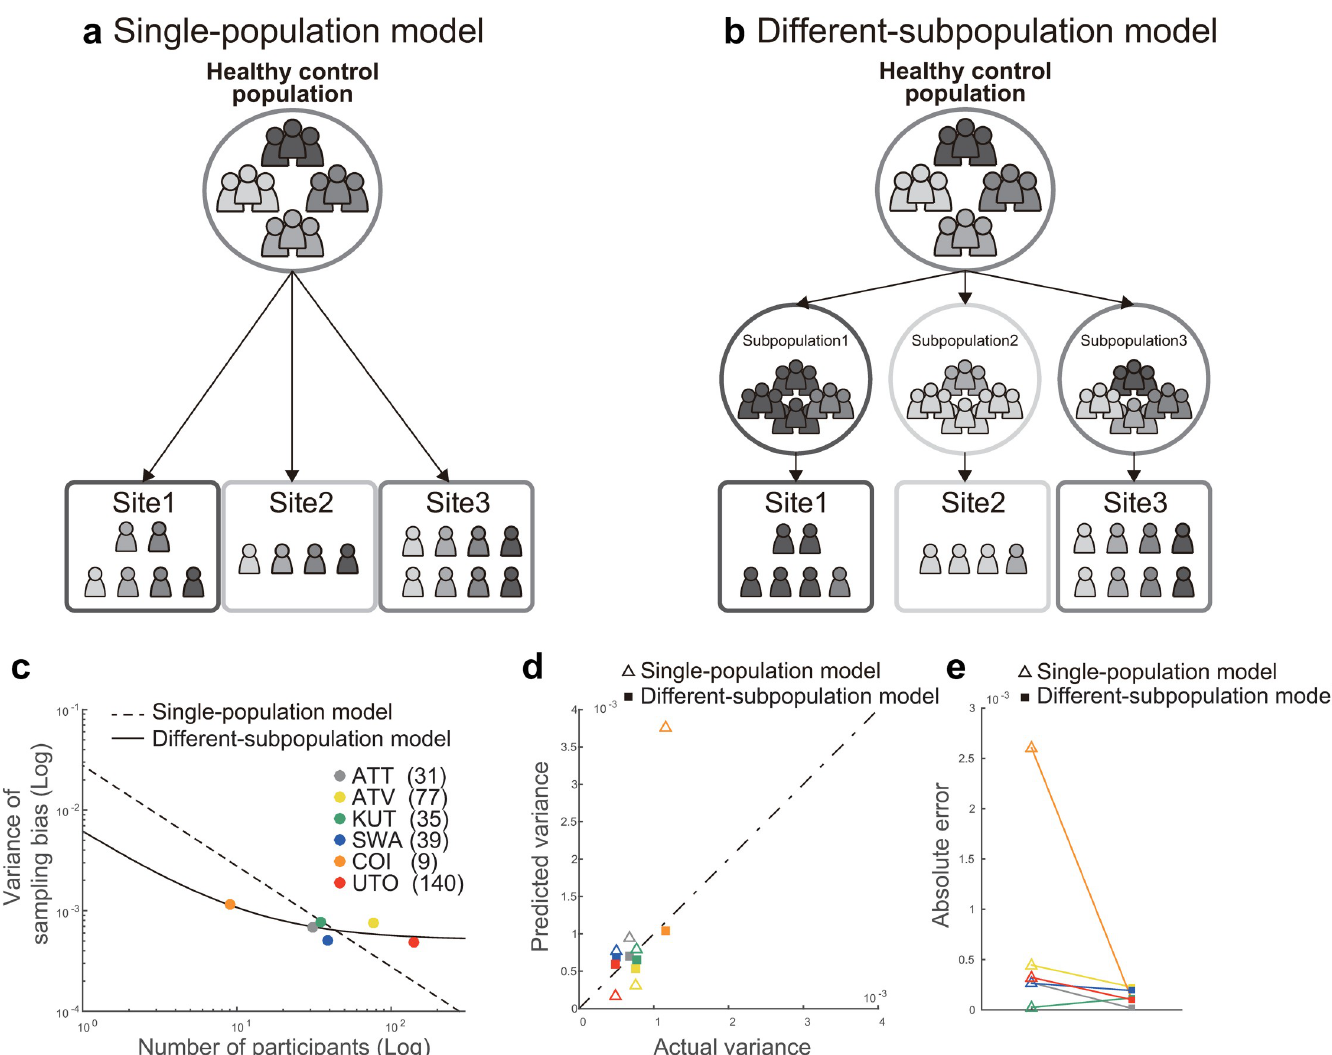
Fig 5. Comparison of the two models of sampling bias. Schematic examples illustrating the (a) Single-population and (b) Different-subpopulation models and (c) The results of model fitting. The x axis represents the number of participants on a logarithmic scale, and the y axis represents the variance of sampling bias on a logarithmic scale. The broken line represents the prediction of the single-population model, whereas the solid line represents the prediction of the different-subpopulation model. Each data point represents one site. (d) Results of the predictions determined by using each model. The x axis represents the actual variance, and the y axis represents the predicted variance. Open triangles correspond to the single-population model, whereas filled squares correspond to the different-subpopulation model. (e) Performance of prediction using the two models, based on the absolute error between the actual and predicted variance. The numerical data used in this figure are included in S1 Data. ATT, Siemens TimTrio scanner at Advanced Telecommunications Research Institute International; ATV, Siemens Verio scanner at Advanced Telecommunications Research Institute International; COI, Center of Innovation in Hiroshima University; KUT, Siemens TimTrio scanner at Kyoto University; SWA, Showa University; UTO, University of